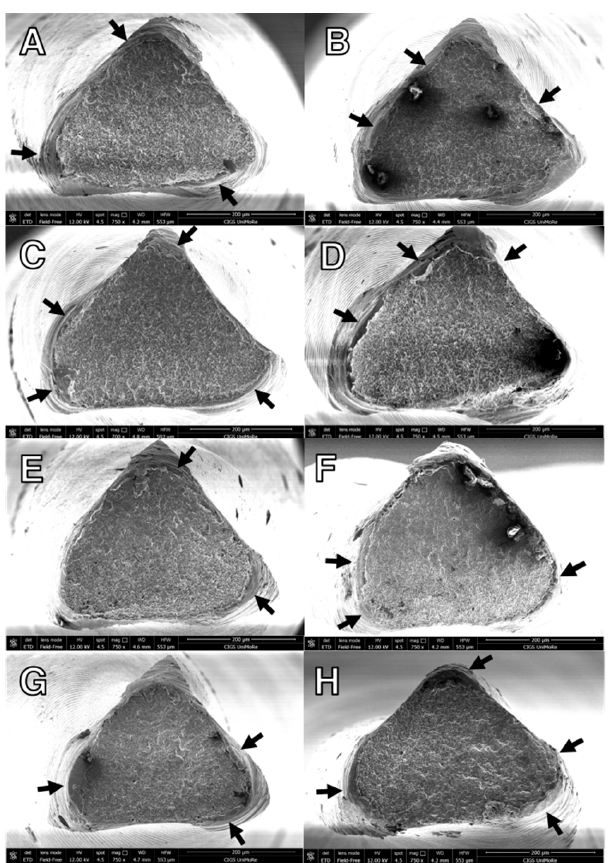
Figure 4. Representative field-emission scanning electron microscope images of the instruments after fatigue tests: ( A , B ) TS2 mini 1.0 T-wire, ( C , D ) TS2 1.2 T-wire, ( E , F ) TS2 mini 1.0 CM-wire, and ( G , H ) TS2 1.2 CM-wire, at 25 °C ± 1 °C ( A , C , E , G ) and 37 °C ± 1 °C ( B , D , F , H ). Typical features of cyclic fatigue fracture of the ductile fatigue area with microdimples and cones are observed with the black arrows indicating the origins of crack initiation.